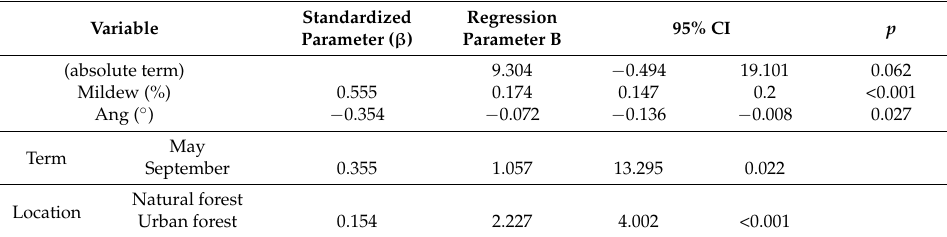
Table 4. Multiple factor analysis of factors affecting S.